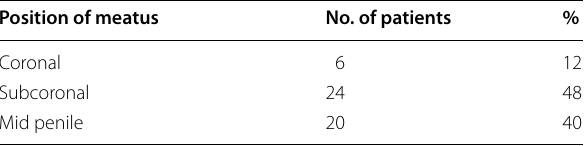
Table 1 Position of meatus Position of meatus No. of patients %